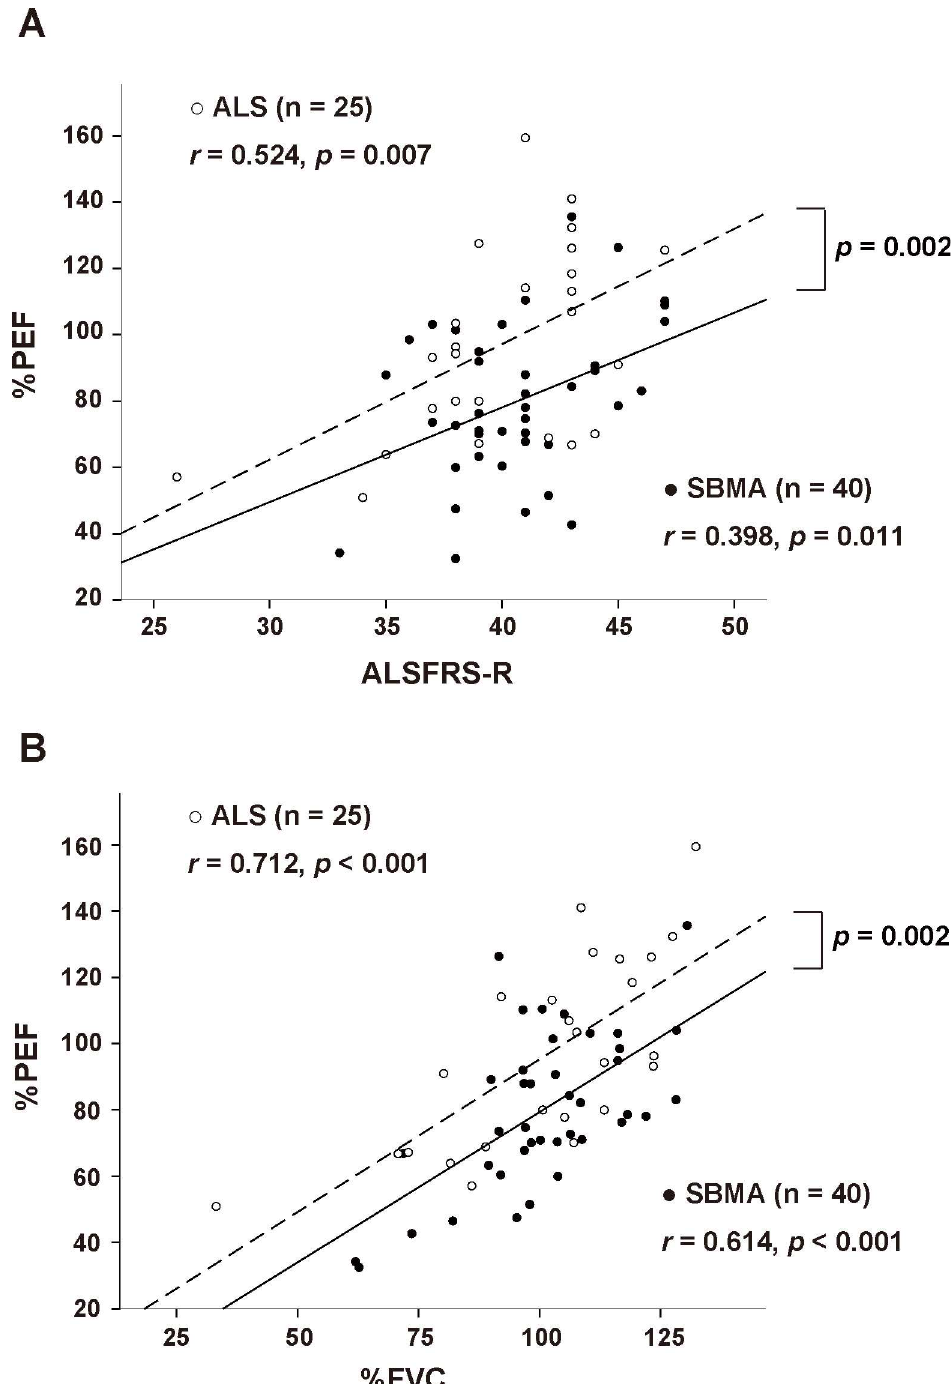
Fig 2. Relationships between %PEF and ALSFRS-R or %FVC in subjects with SBMA and ALS. Comparison of the relationshipsbetween %PEF andtotal score of ALSFRS-R(A) or %FVC (B) in SBMA and ALS. The difference in %PEF betweenSBMA andALS was significantafter adjustment for the ALSFRS-Rand %FVC with ANCOVA. %PEF, predictedvaluesof peak expiratoryflow; ALSFRS-R, the revised Amyotrophic LateralSclerosis Functional RatingScale; %FVC, predicted forced vital